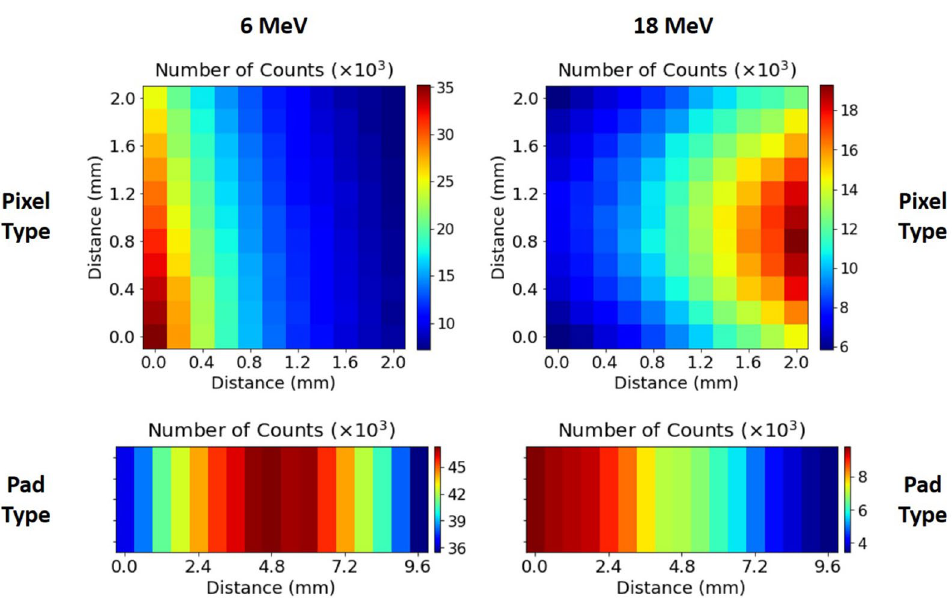
Figure 6. Number of counts measured with 6 MeV (left) and 18 MeV (right) proton beams. Top: pixel-type system. Bottom: 1 cm representative region of the pad-type system (not to